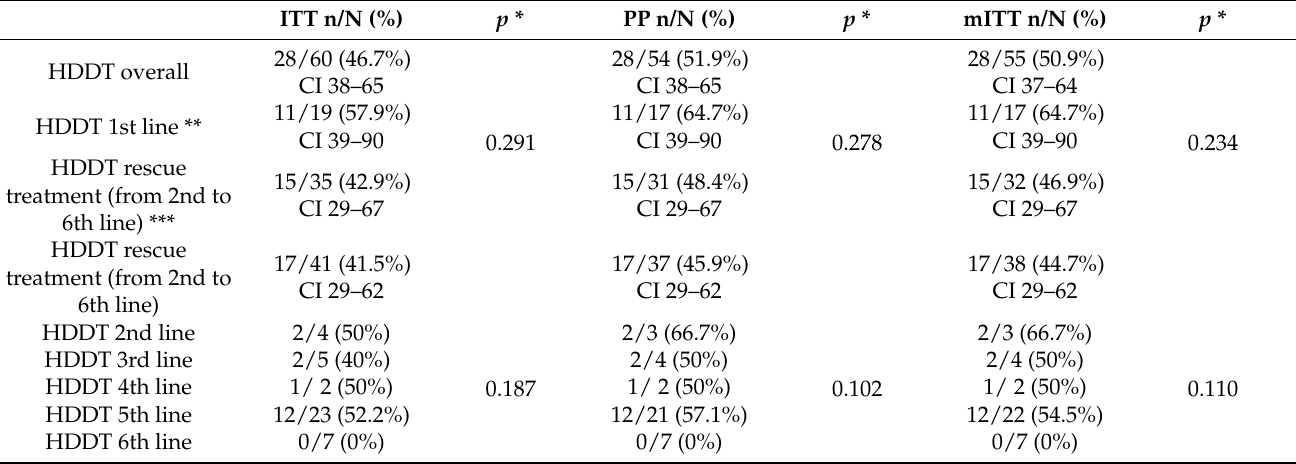
Table 2. HDDT effectiveness in first ‐ line and as rescue treatment.